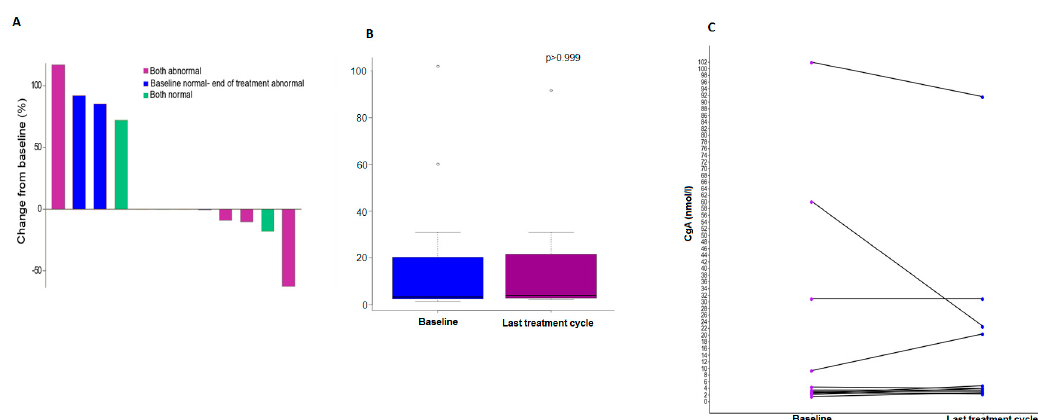
Figure 2. A waterfall plot showing the change from baseline CgA levels at the last cycle of treatment, with ( A ) showing comparative boxplots for CgA levels at baseline and at the last treatment cycle, ( B ) showing the time course of CgA levels at baseline, and ( C ) showing that at the last cycle of treatment per